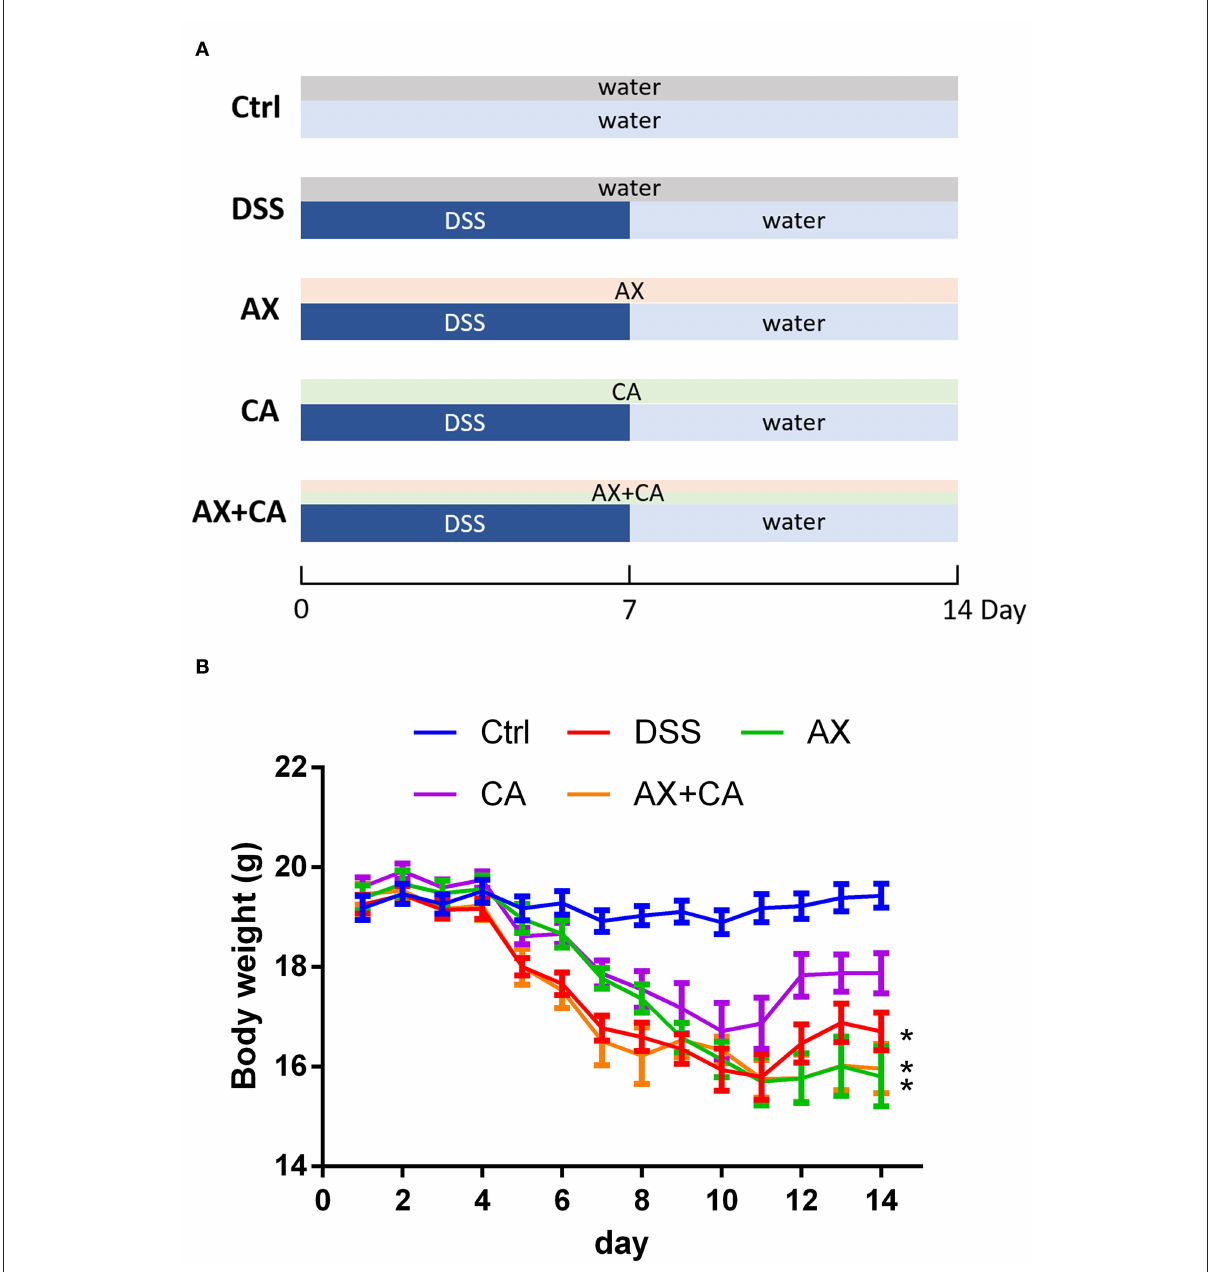
FIGURE1 (A) Experimental design and treatment structure; (B) Changes in body weight over time for each group. The * symbol indicates the body weight of mice in the group was significantly different from those in the Ctrl group after feeding and treatment for 14 days ( p <